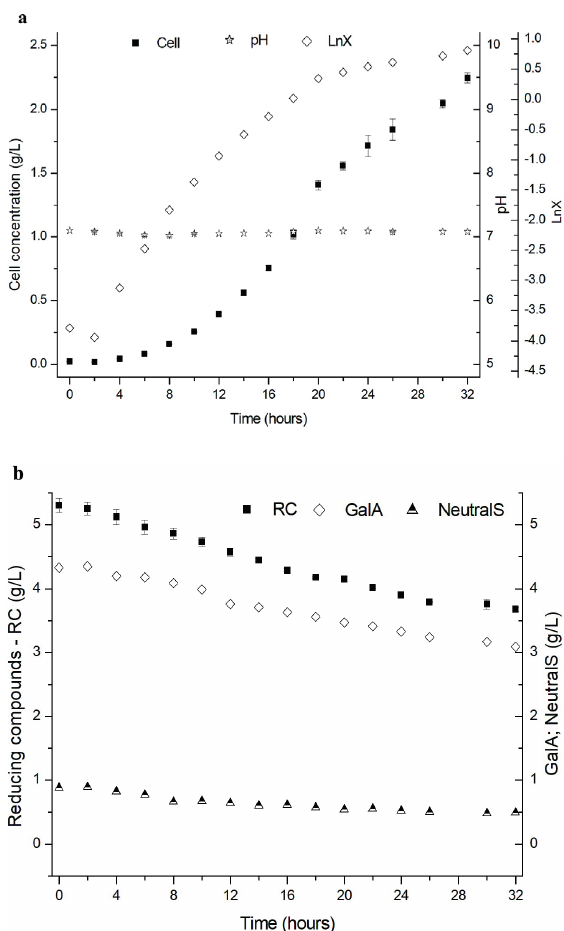
Figure 5 - Cell growth and pH ( a ); and consumption of substrates ( b ), during culture of C. necator in mineral media containing enzymatic pectin